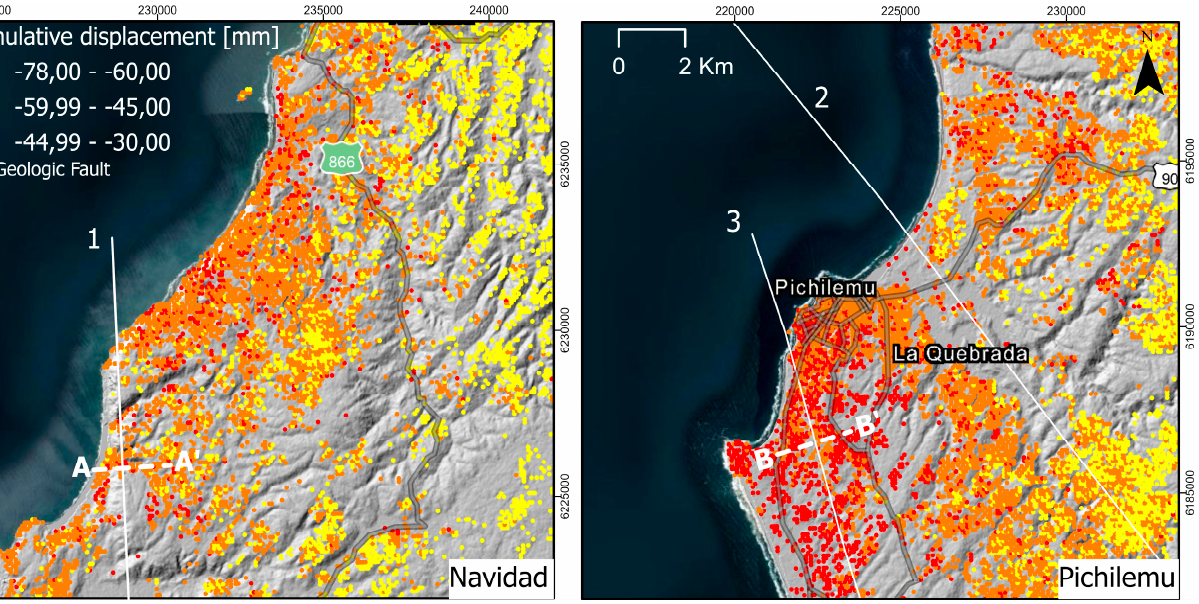
Figure 14. Profile lines are perpendicular to Fault 1 and Fault 3. Figures ( A ) and ( B ) show the terrain profile (A-A’, B-B’), and ( C ) and ( D ) show the estimated ground deformation obtained with MT-InSAR.